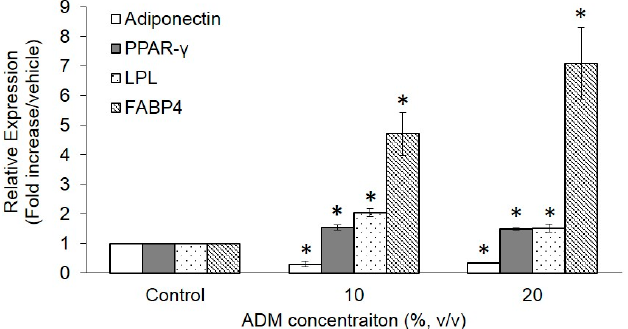
Figure 4. Effect of ADM concentrations on adipogenic marker genes in human dermal fibroblasts, Hs68. Hs68 fibroblasts were induced to undergo the differentiation process in the absence or presence of ADM for three days. RNA samples were prepared from cells at the indicated time point after treatment. Real-time RT-PCR analysis was performed to examine gene expression of four adipogenesis markers (relative to GADPH). The data were presented as the means ± standard deviation, n = 3–6. * p < 0.05 with respect to control.